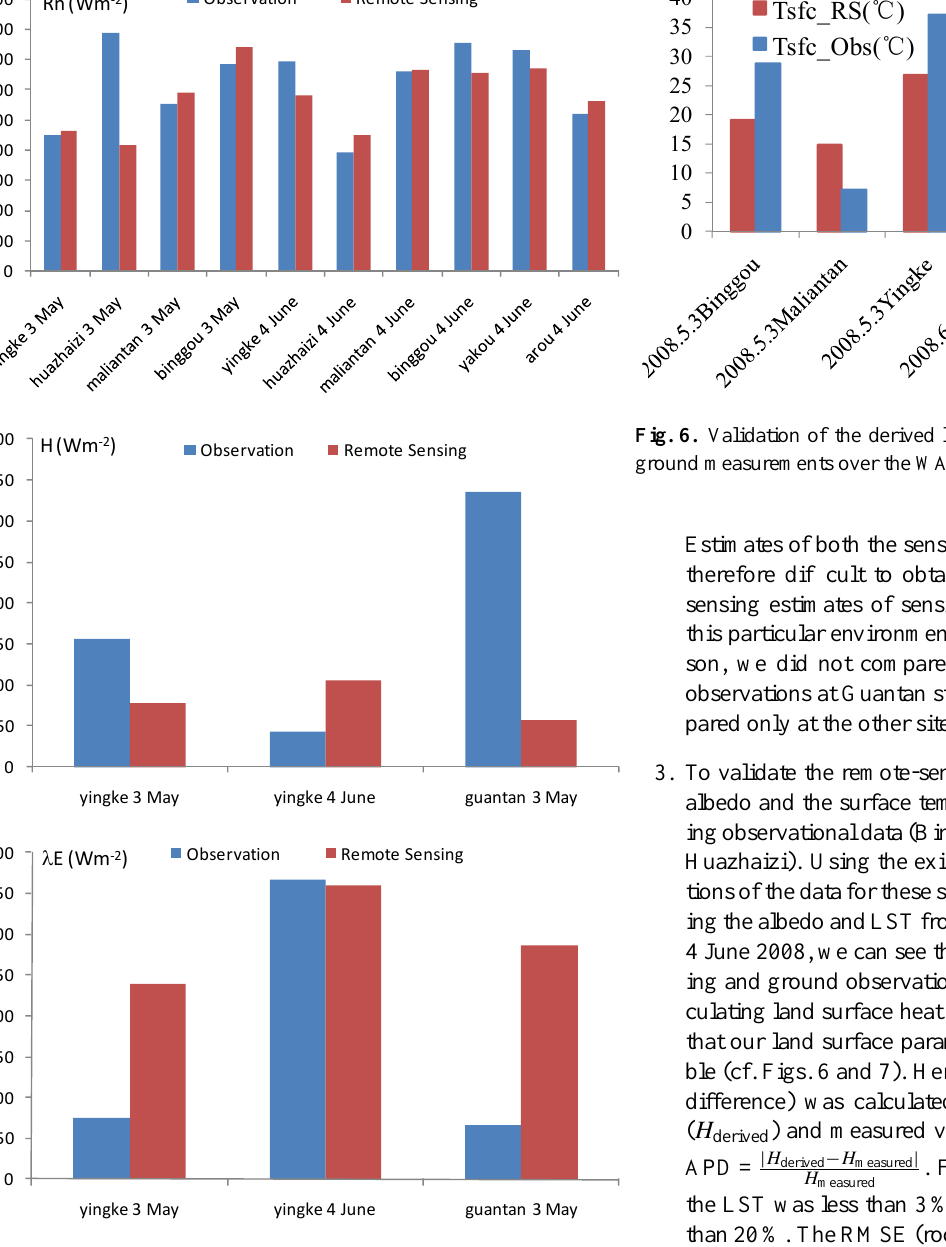
Fig. 5. Validation of the derived net radiation R n , sensible heat flux H and latent heat flux λ E against ground measurements over the WATER stations, Yingke, Huazhaizi, Guantan, Maliantan, Arou, Binggou and Yakou. Note: The sites with missing observa- tion data were not listed in the figures.